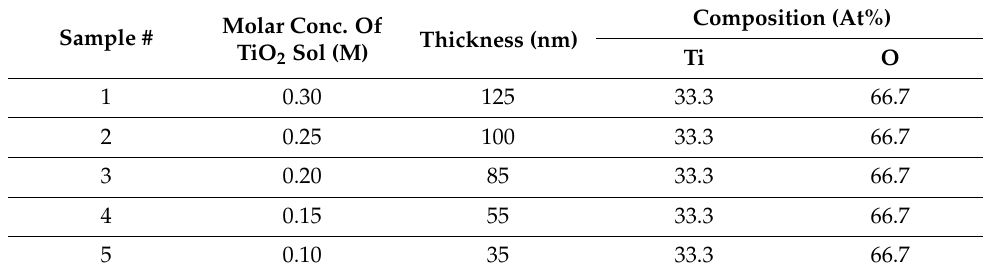
Figure 2. Rutherford backscattering spectrometry (RBS) spectra of TiO 2 films deposited on flat Si(100) surfaces using varied molar concentrations (0.10–0.30 M) of TiO 2 sol for thickness optimization. Table 2. TiO 2 thickness derived from RBS analysis using GISA-3 software.